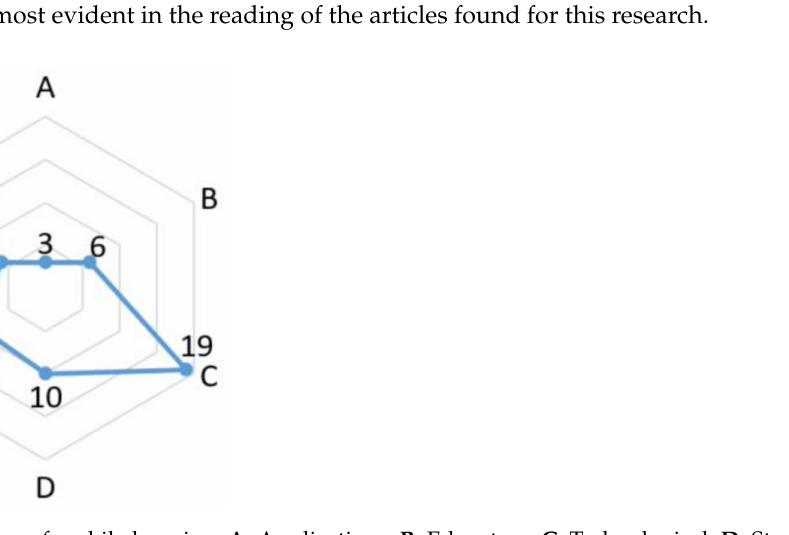
Figure 3. Issues of mobile learning, A : Applications; B : Educators; C : Technological; D : Students; E : Educational Institutions; F :